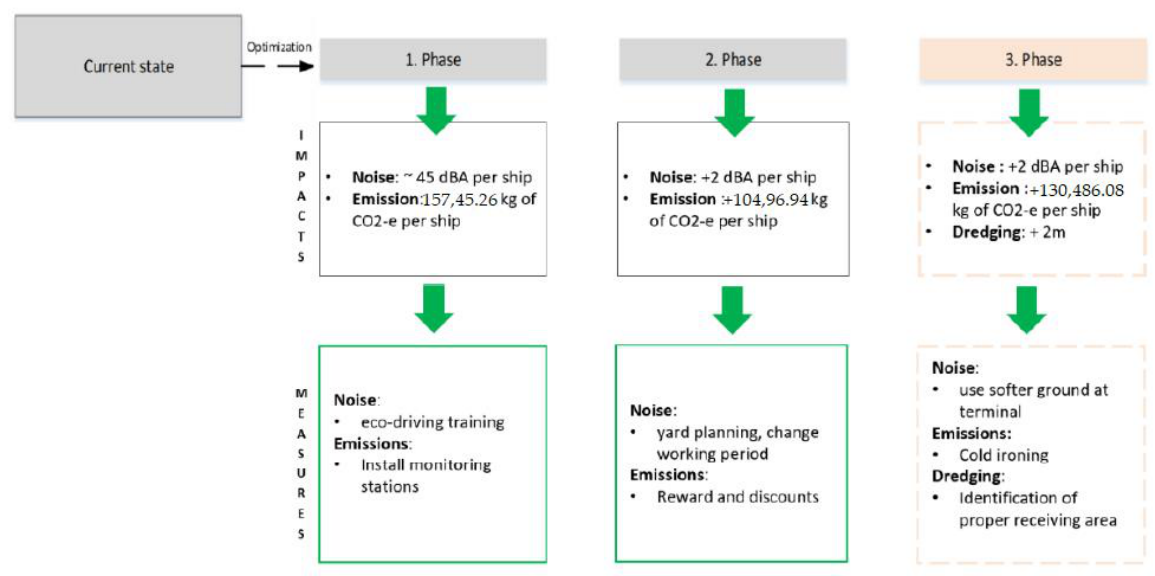
Figure 8. Terminal Decision Support Tool’s (TDST) result for the three